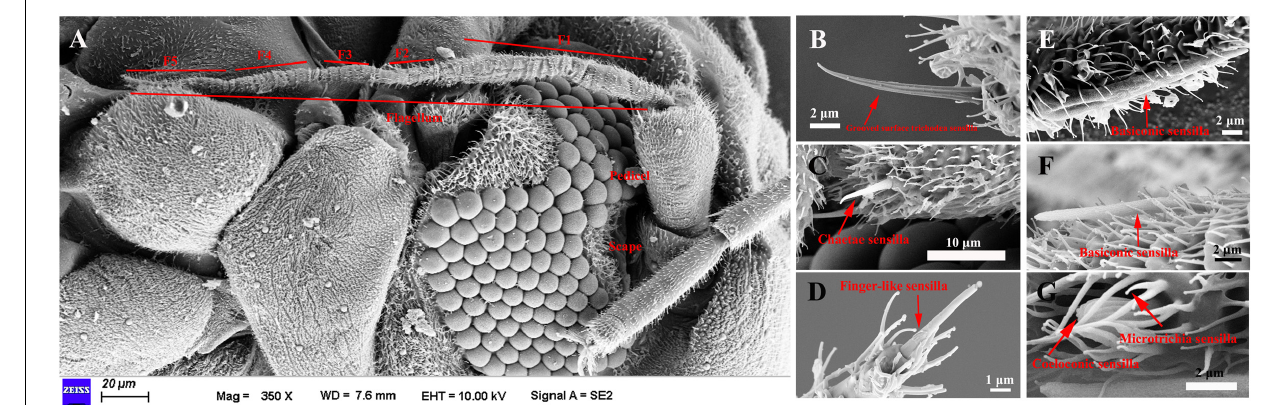
FIGURE 1 | The types of sensilla present on A. spiniferus antennae. (A) Female antenna. (B) Grooved surface richodea sensilla (C) Chaetae sensilla. (D) Figure-like sensilla. (E) Basiconic sensilla. (F) Basiconic sensilla. (G) Coeloconic and microtrichia sensilla.